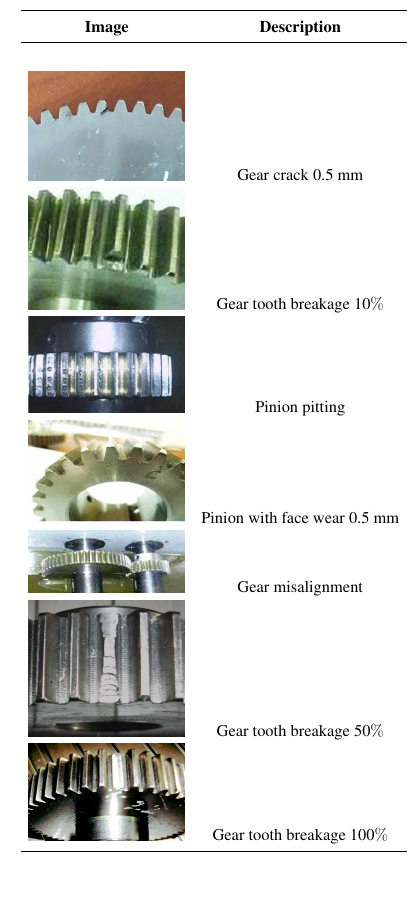
Table 2. Gear faults.